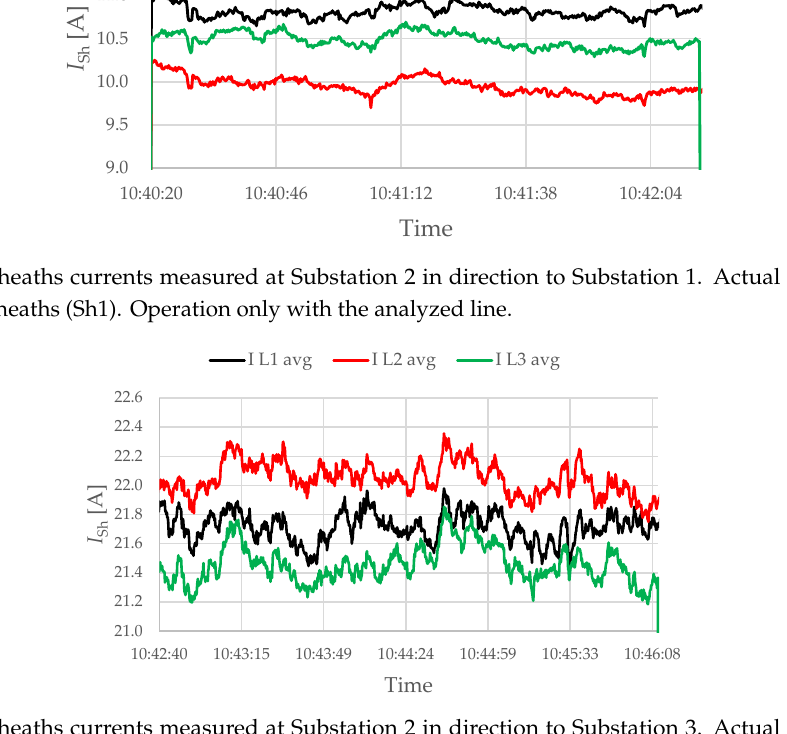
Figure 8. Sheaths currents measured at Substation 2 in direction to Substation 3. Actual operating system of sheaths (Sh1). Operation only with the analyzed line.